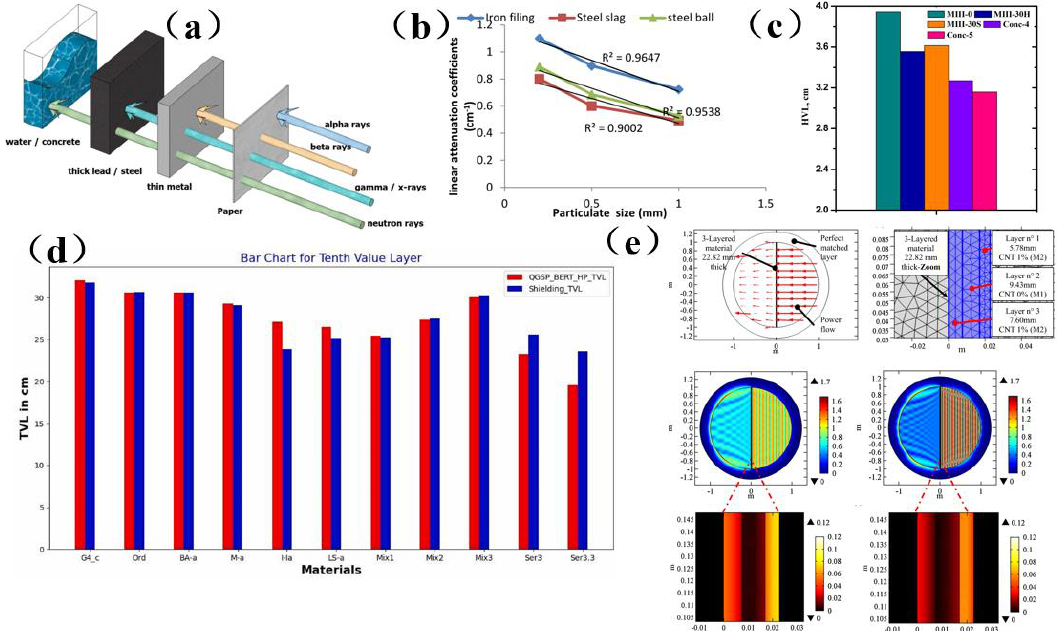
Figure 10. ( a ) Types, penetration behavior, and properties of various types of radiation [115]. Copyright 2022, MDPI. ( b ) Linear attenuation coefficient is a function of filler particle size [117]. Copyright 2014, Trans Tech Publications. ( c ) The half value layer for shielding materials at 0.662 MeV.